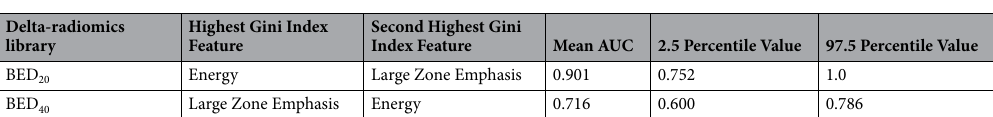
Table 2. Performance of delta-radiomics texture features ranked by the Gini Index using bootstrapped logistic regression analysis for each library. AUC, area under the curve; BED, biologically effective dose (calculated using α/β =